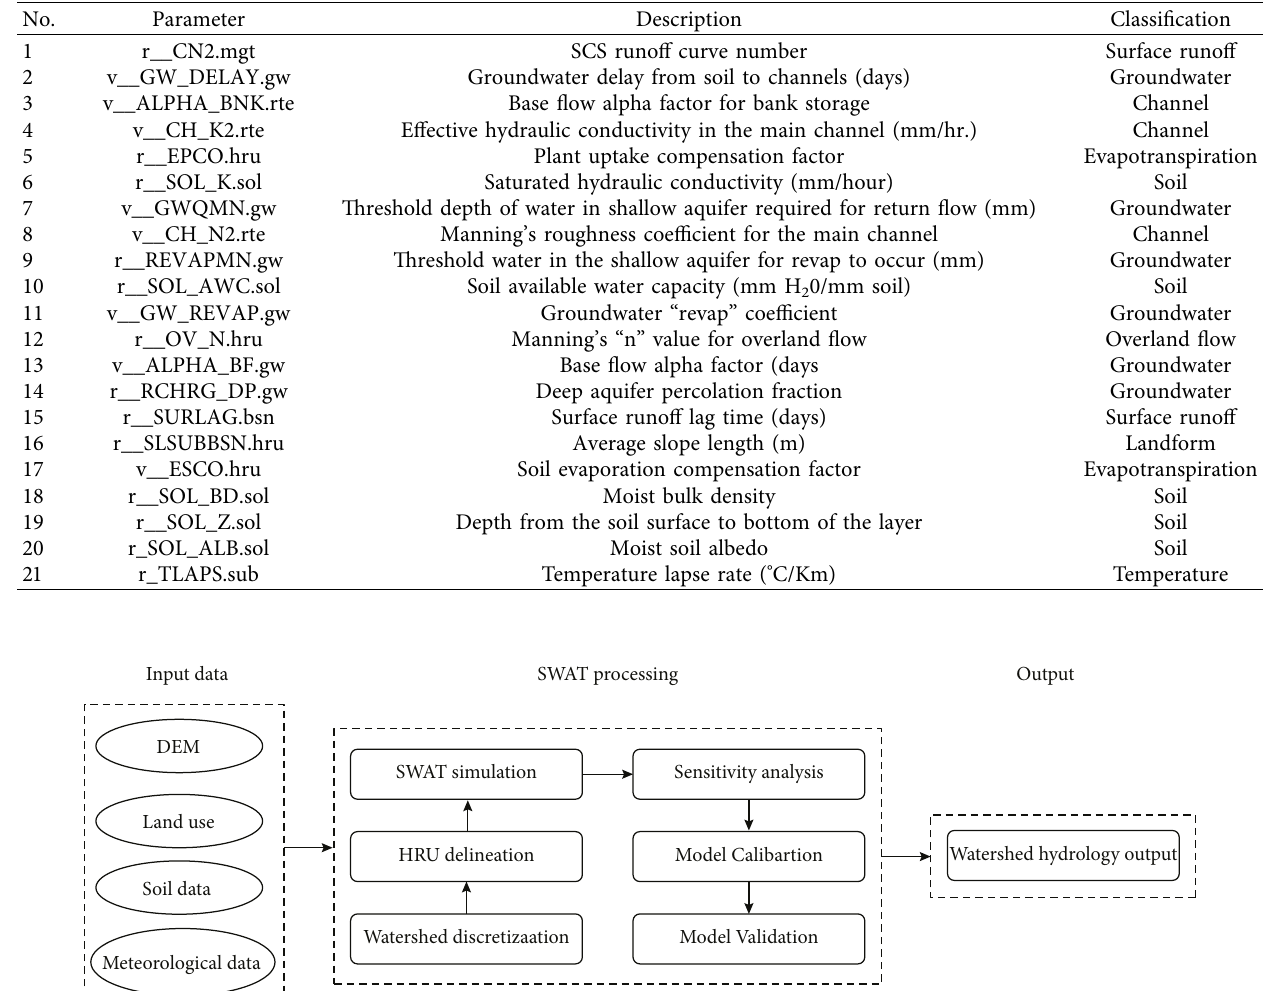
Table 5: Selected sensitive parameters of Nashe